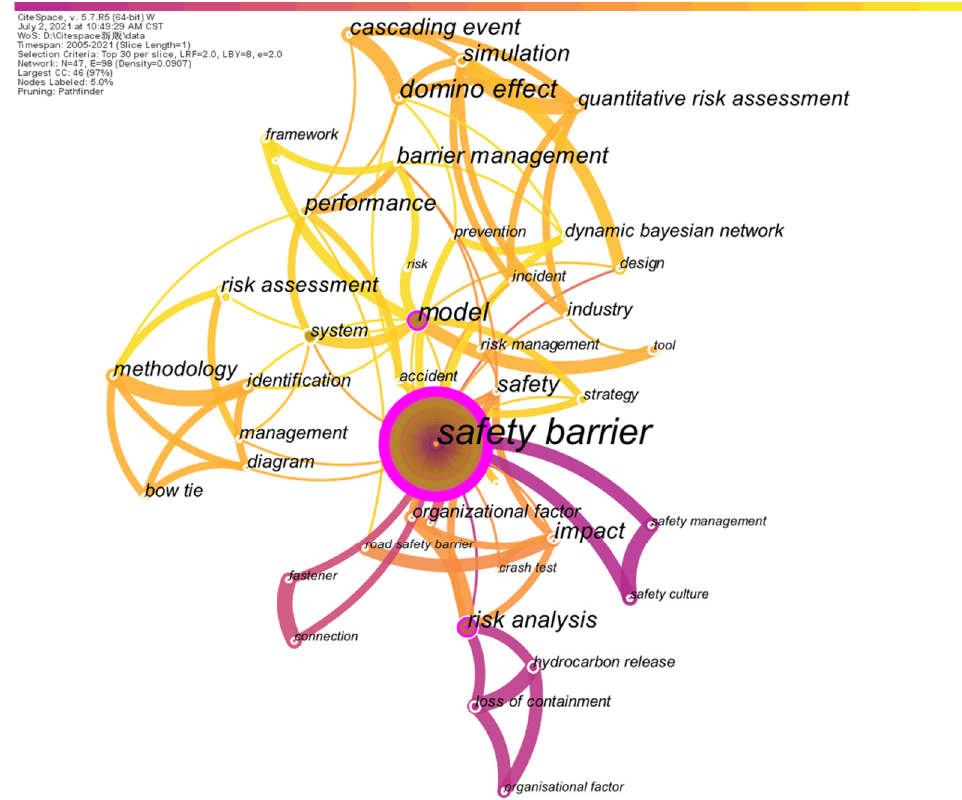
Figure 10. Mapping of keyword co-occurrences.